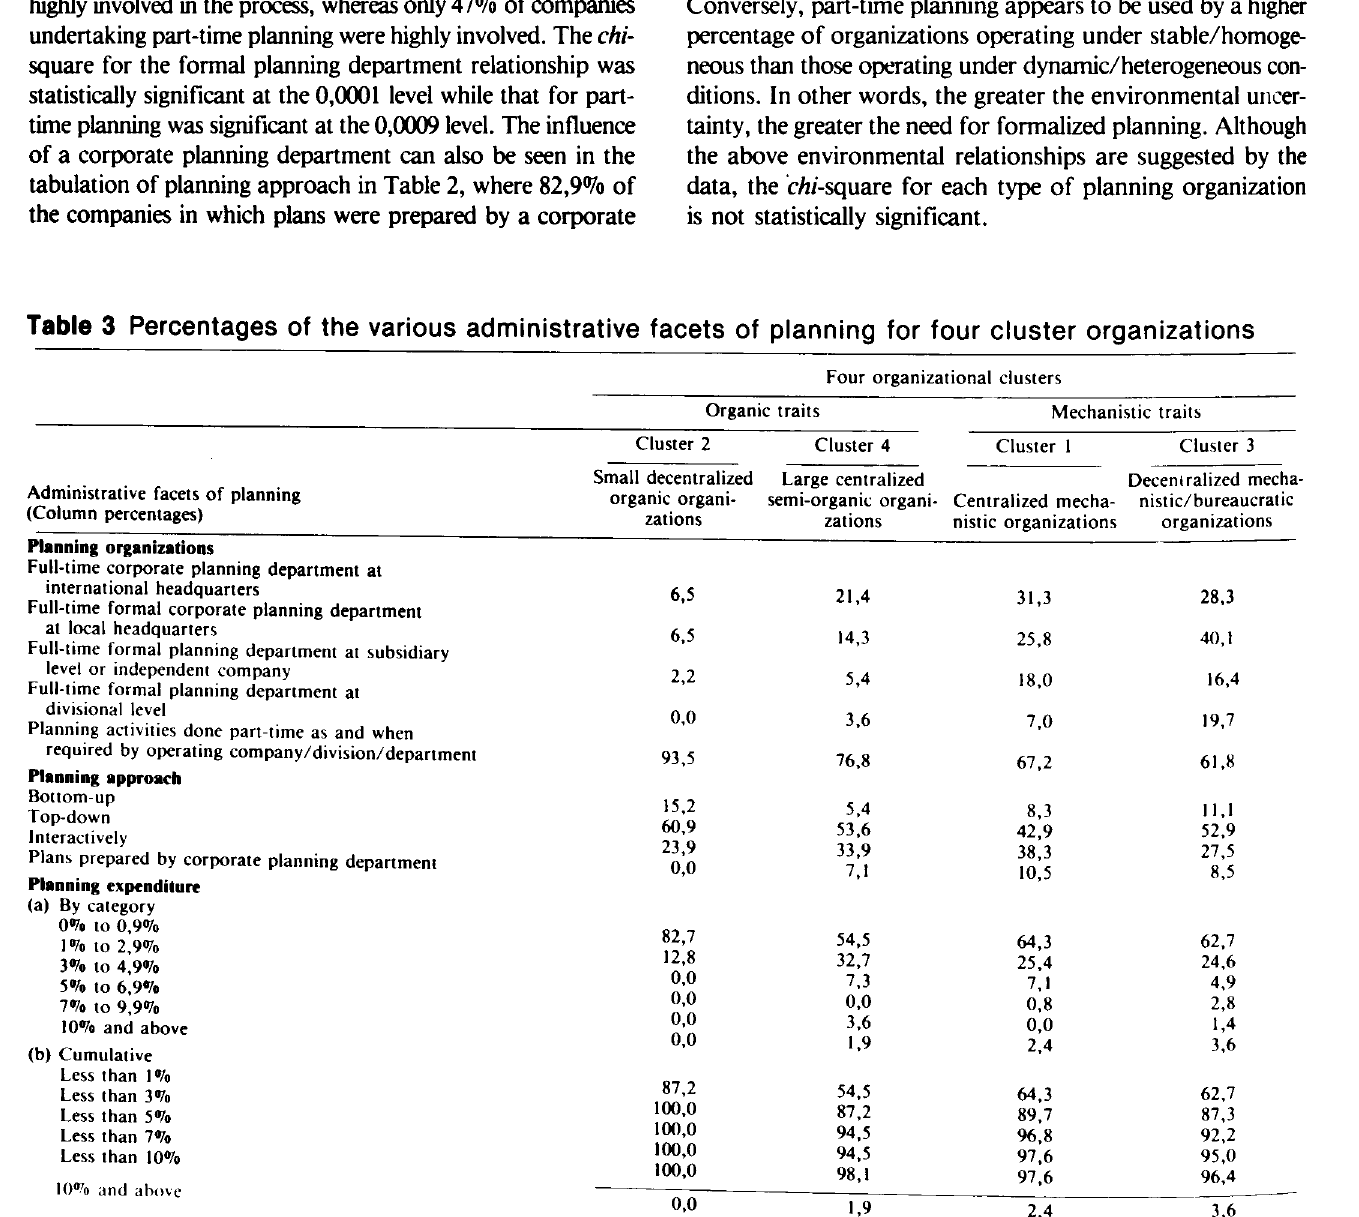
Table 3 Percentages of the various administrative facets of planning for four cluster